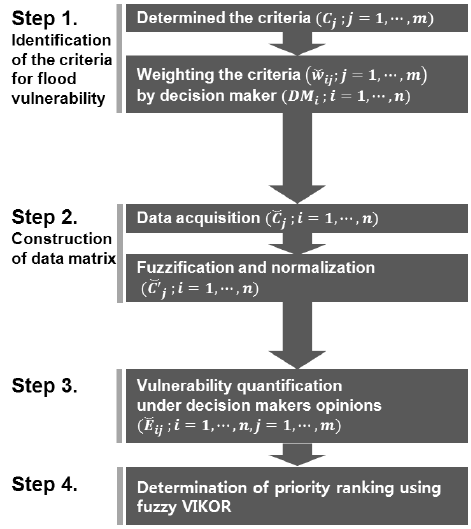
Figure 1. Study procedure for group decision making.